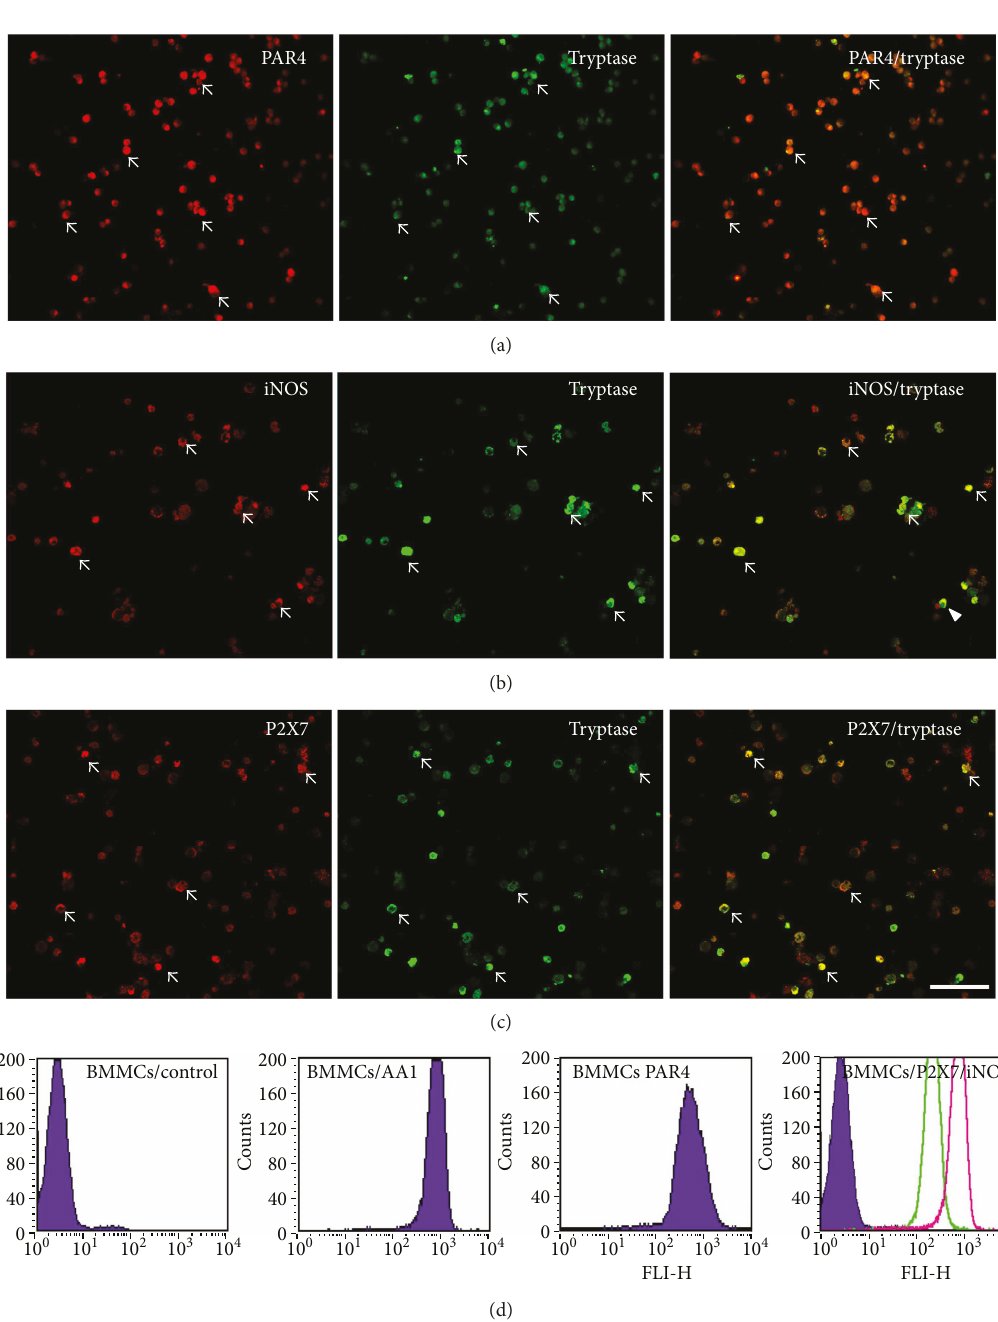
Figure 4: Cultured rat BMMCs expressed tryptase, PAR4, iNOS, and P2X7. (a – c) Expression of tryptase (AA1) and its colocalization with PAR4, iNOS, or P2X7 in cultured BMMCs (bar 100 μ m). (d) Flow cytometric analysis showed that the BMMCs expressed relatively high levels of tryptase, PAR4, iNOS, and